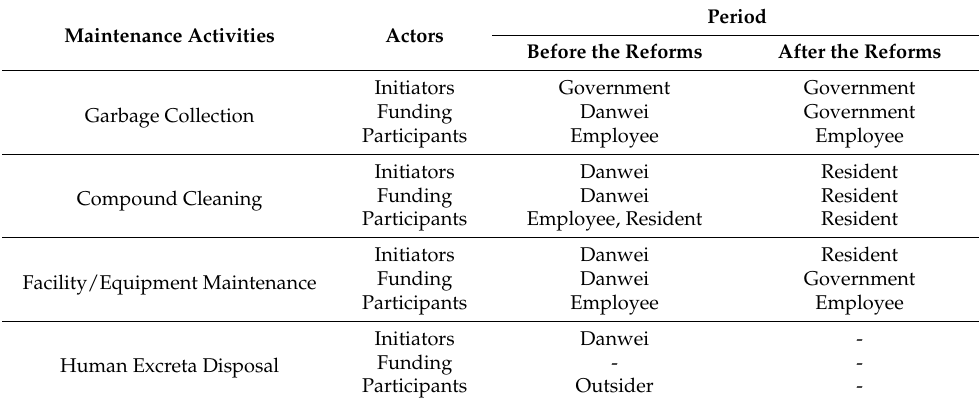
Table 7. Main actors in the compound